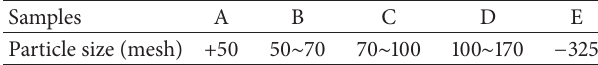
Table 2: Particle size distributions of sized granules.